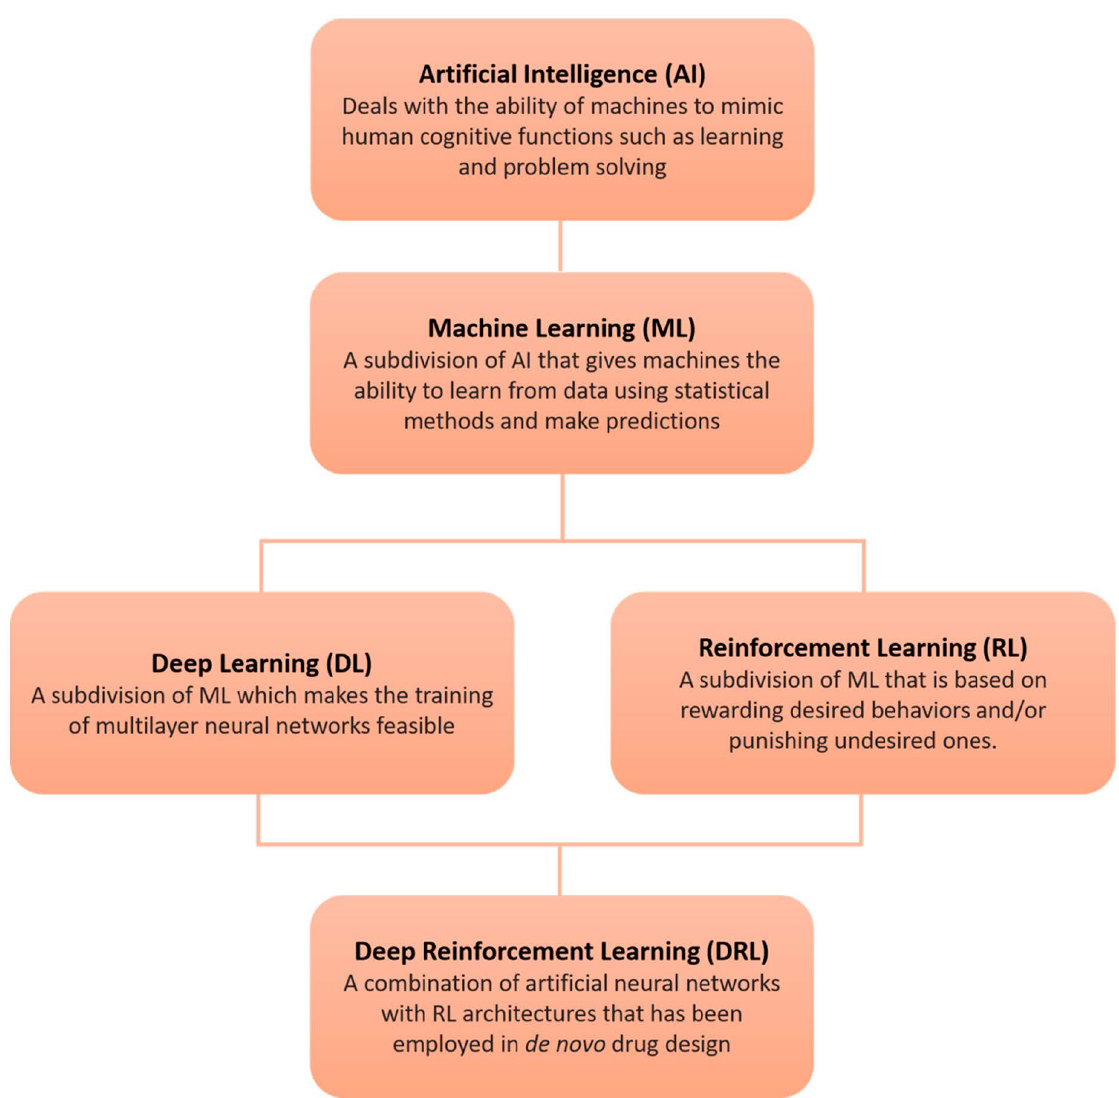
Figure 3. Artificial intelligence methods such as machine, deep, and reinforcement learning have been successfully employed in de novo drug